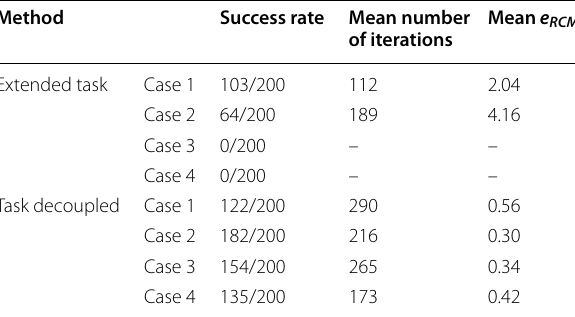
Table 2 Reach random targets with same initial joint